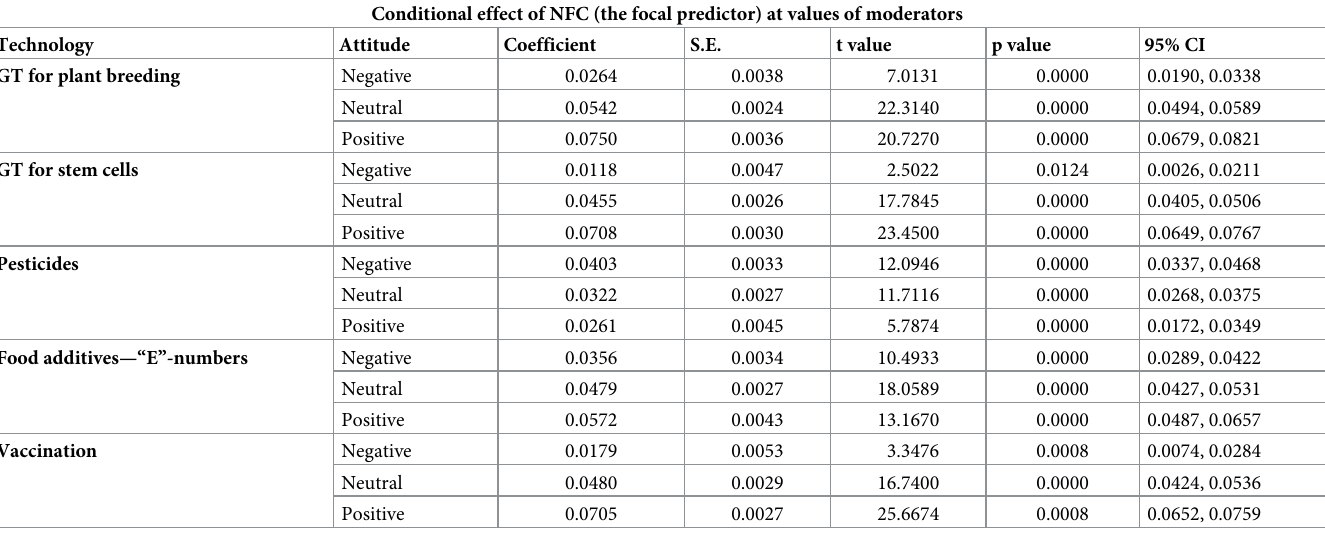
Table 4. Moderated moderation for the distance between harms and benefits for humans. Conditional effect of the focal predictor at each value of the moderators. Conditional effect of NFC (the focal predictor) at values of